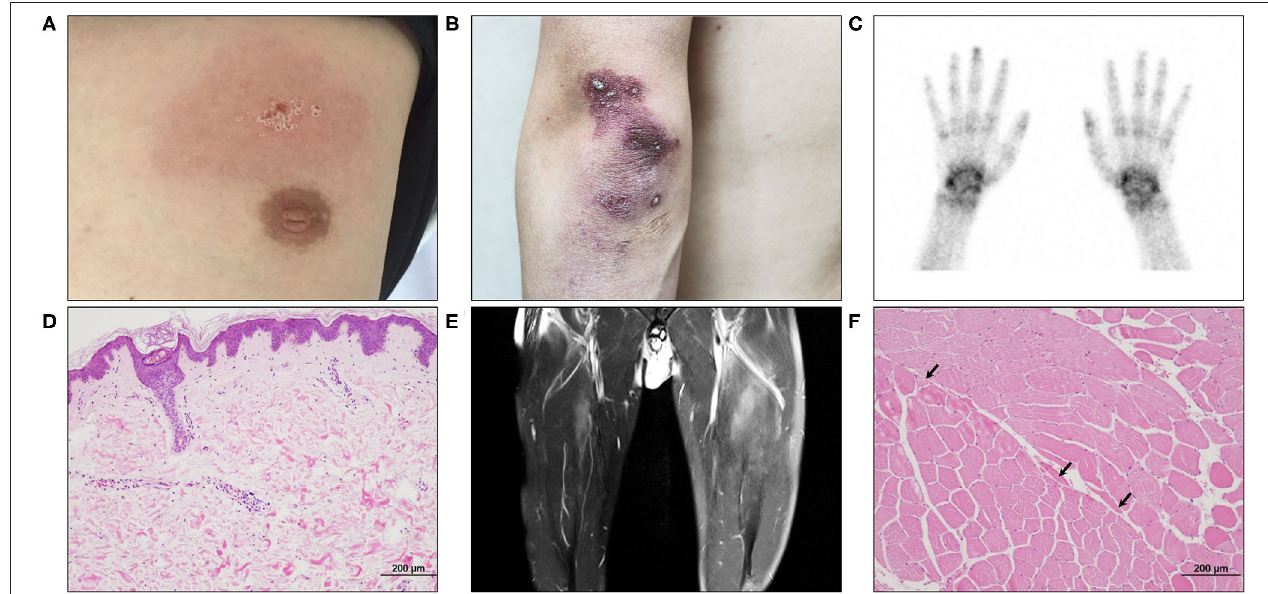
FIGURE 2 | The initial cutaneous, imaging, and pathological findings of the patient. (A) An erythematous patch with scales was seen in the anterior chest. (B) A diffuse purpuric patch with crusts was seen in the left elbow. (C) The three-phase bone scintigraphy revealed increased uptake in both wrists and interphalangeal joints. (D) Skin biopsy of the chest displayed a couple of small vessels with perivascular inflammatory cell infiltration in the upper dermis (H&E, × 100). (E) Thigh MRI showed multifocal infiltrations in the anterior thigh muscles with left side dominancy. (F) Biopsy of the left vastus lateralis muscle revealed a small number of atrophic angular myocytes (arrows) in the perifascicular area (H&E, ×